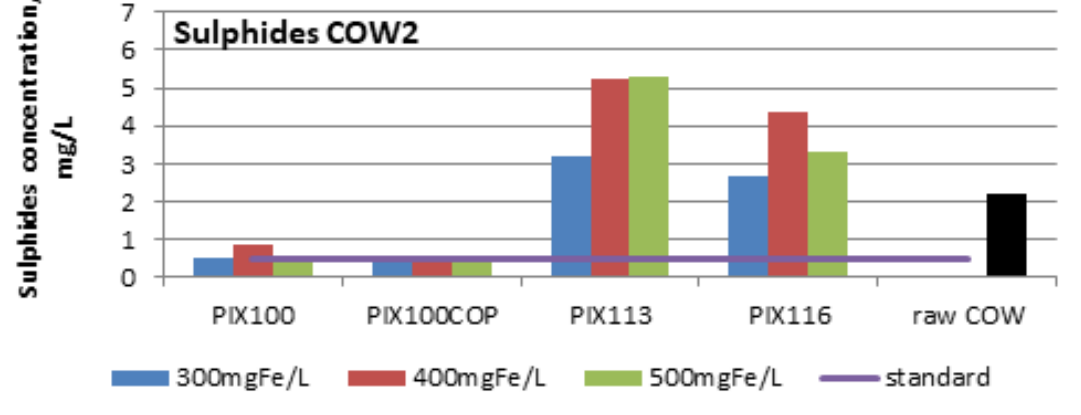
Figure 11: Final concentration of sulphides in COW2.